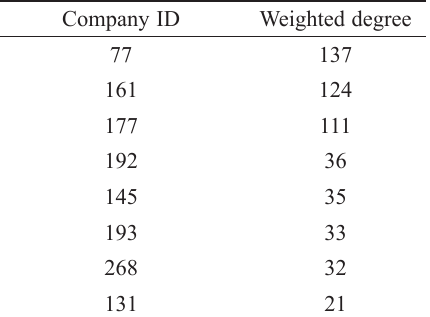
Table 3. Companies with the highest weighted-degree